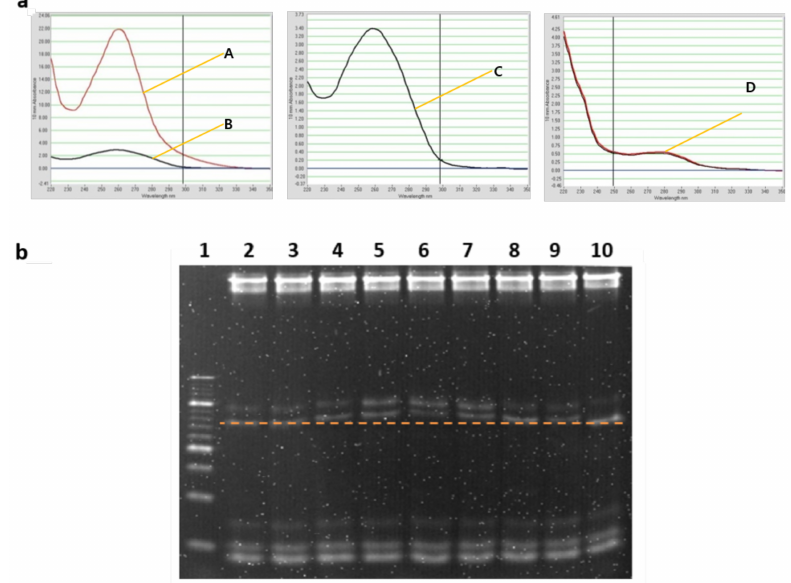
Figure 6. DNA quantification and hybridization of final complementary strands for verifying the presence of a 3-order double-stranded random DNA library. ( a ) Nanodrop analysis for quantification of DNA amount at each step of the protocol; pre-hybridization of variables pre-ligase (A), post-ligase (B), post-purification (C) post-separation (D) ( b ) gel electrophoresis of 3-order random library hybridized with each type of complementary strands (C1-C9 in lanes 2–10), so lane 2 contains the